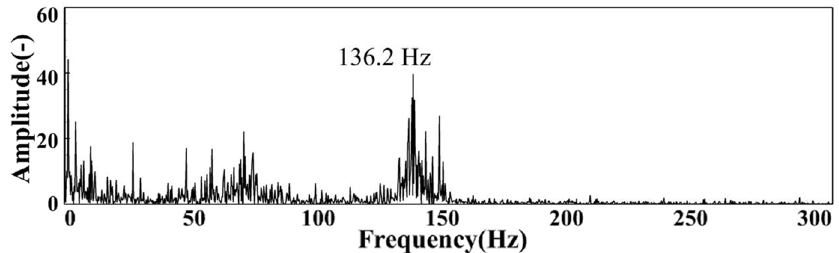
Figure 9. The spectrum of CH* pulsation under MA02 operating conditions.